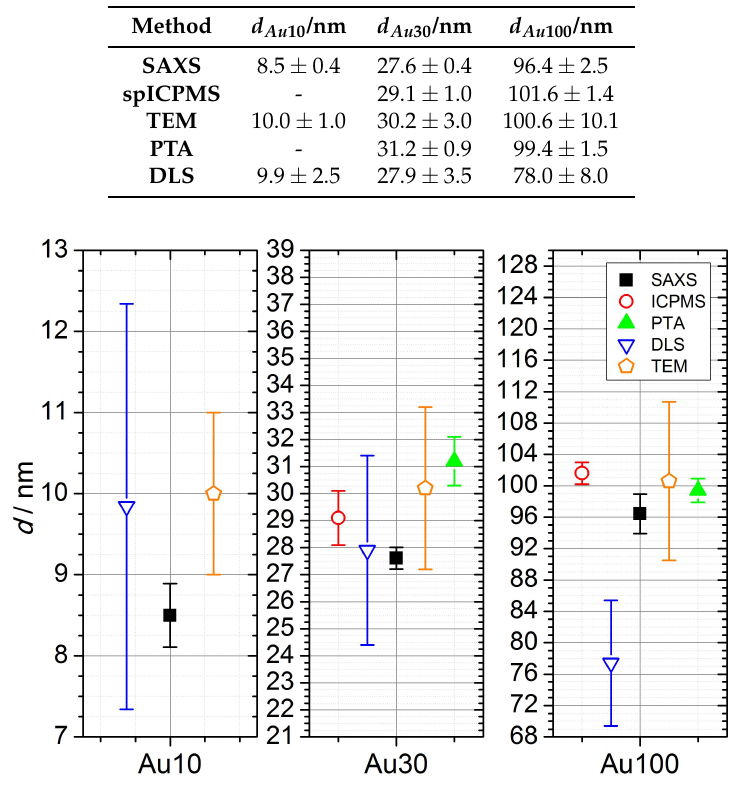
Figure 1. Comparison of the diameters and corresponding uncertainties for reference and laboratory methods. Open symbols symbolize methods without full uncertainty budget for diameter